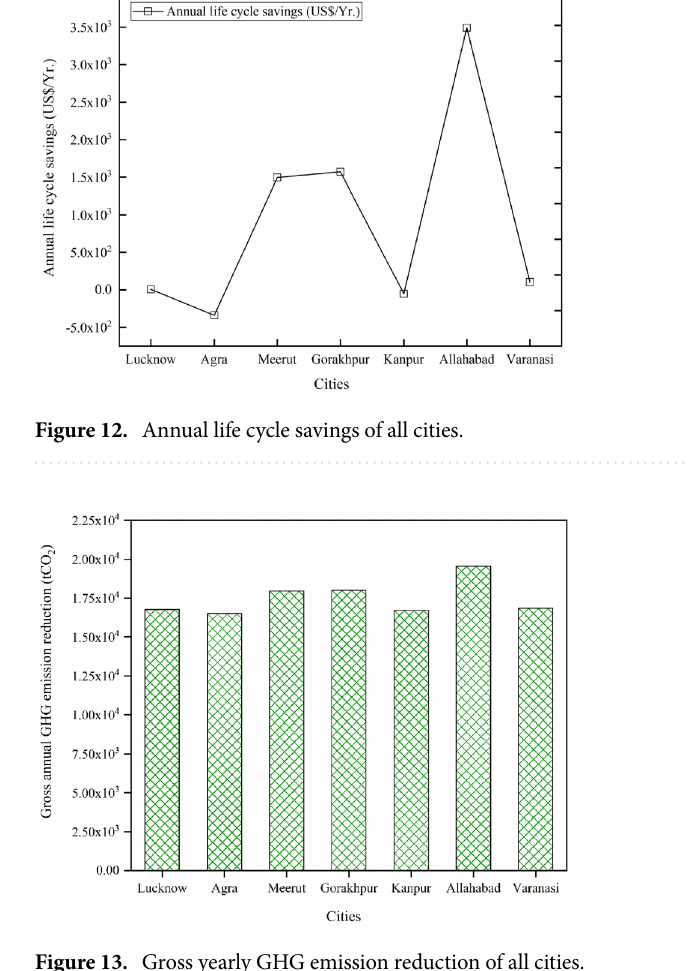
Figure 13. Gross yearly GHG emission reduction of all